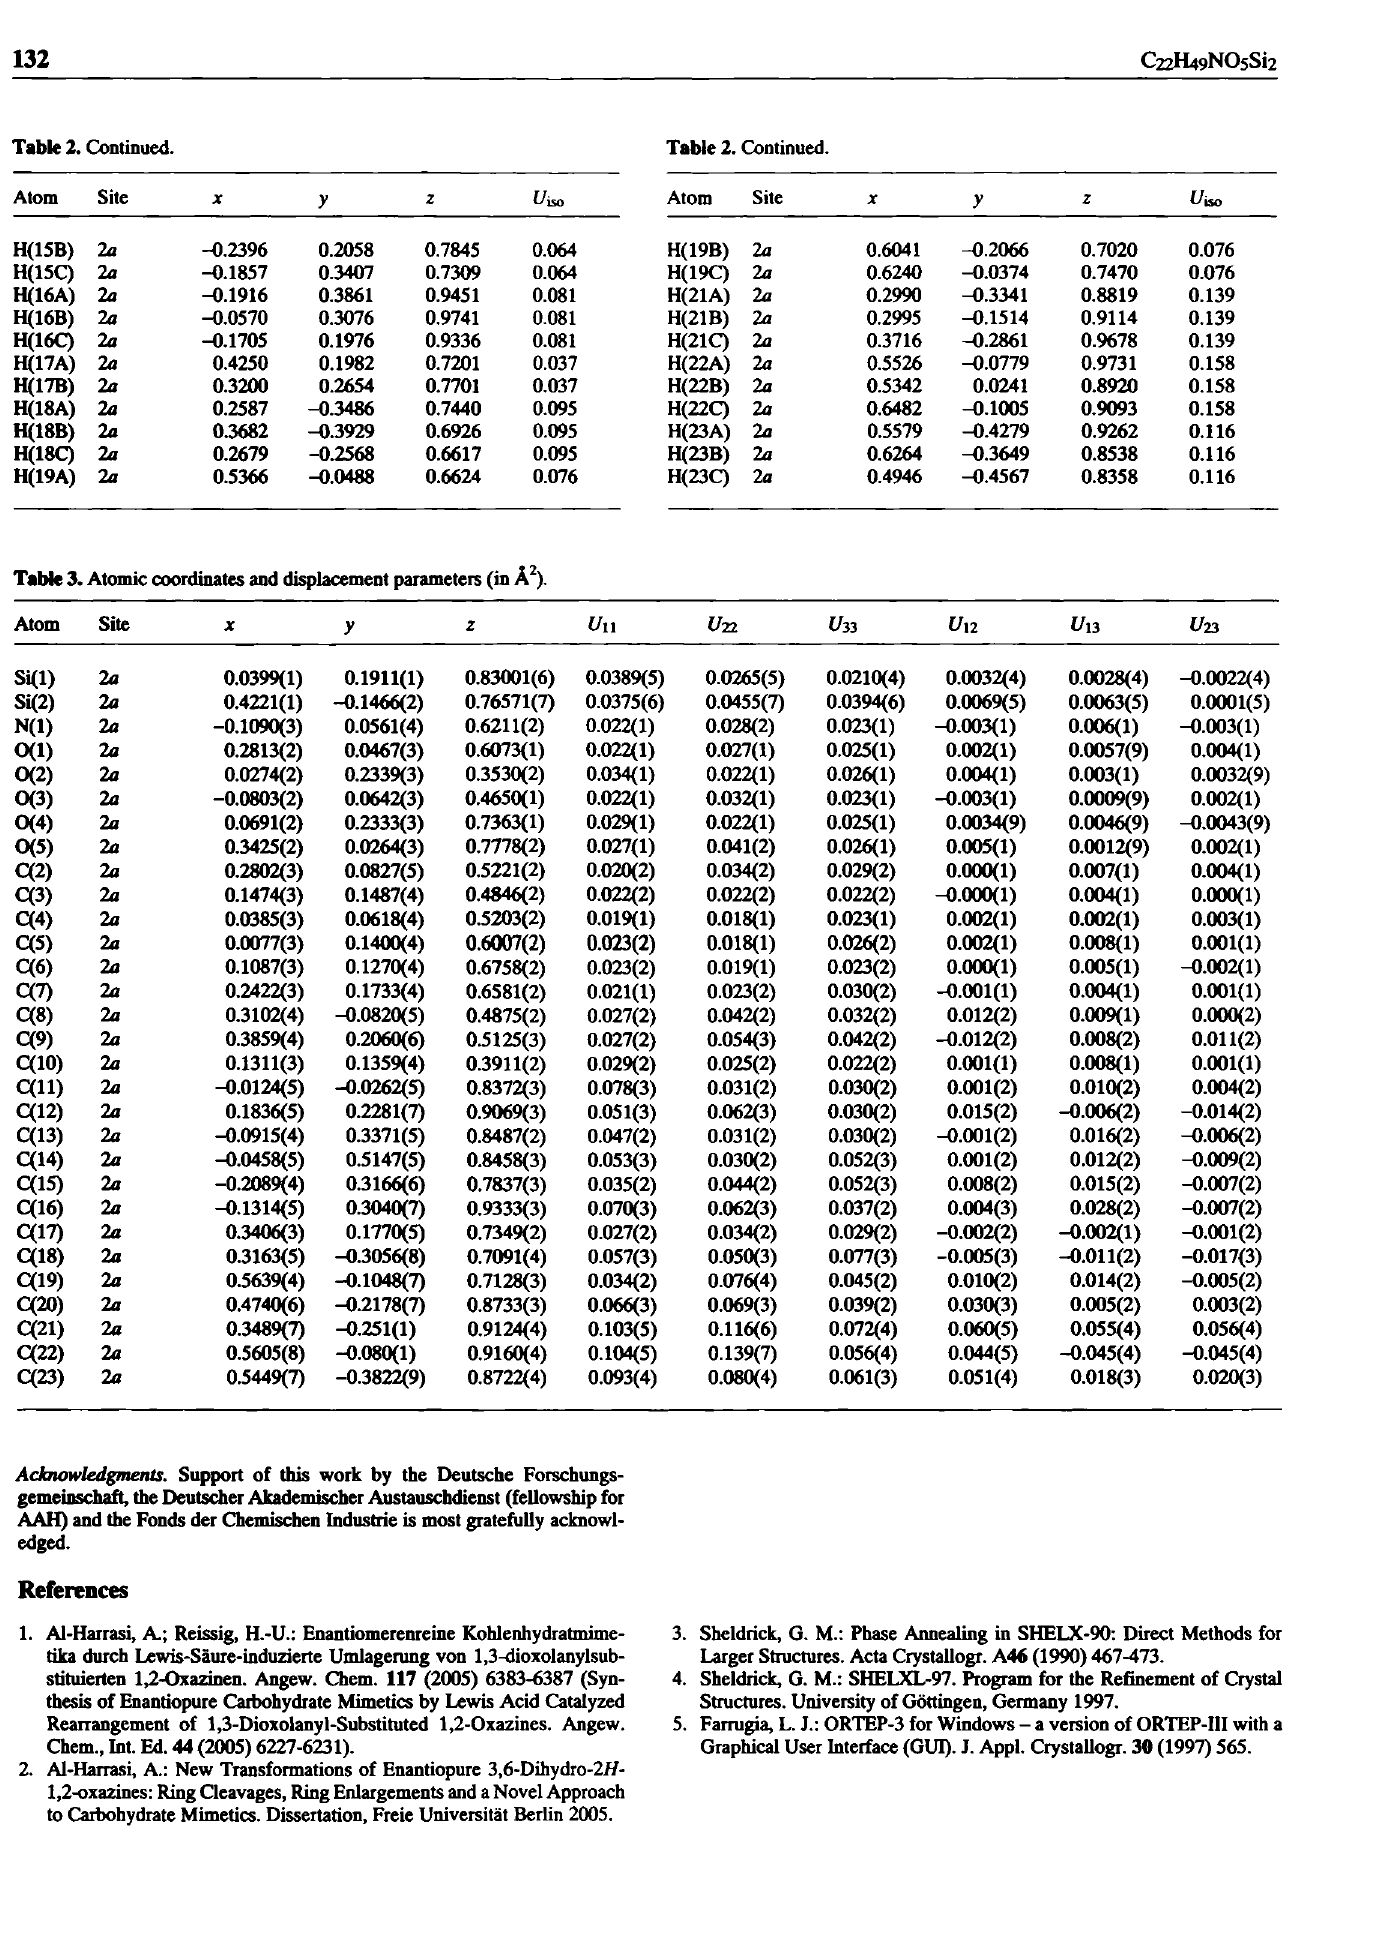
Table 3. Atomic coordinates and displacement parameters (in A 2